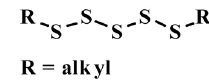
Fig. 1 Molecular structure of DPS. Table 1 Physical characteristic of